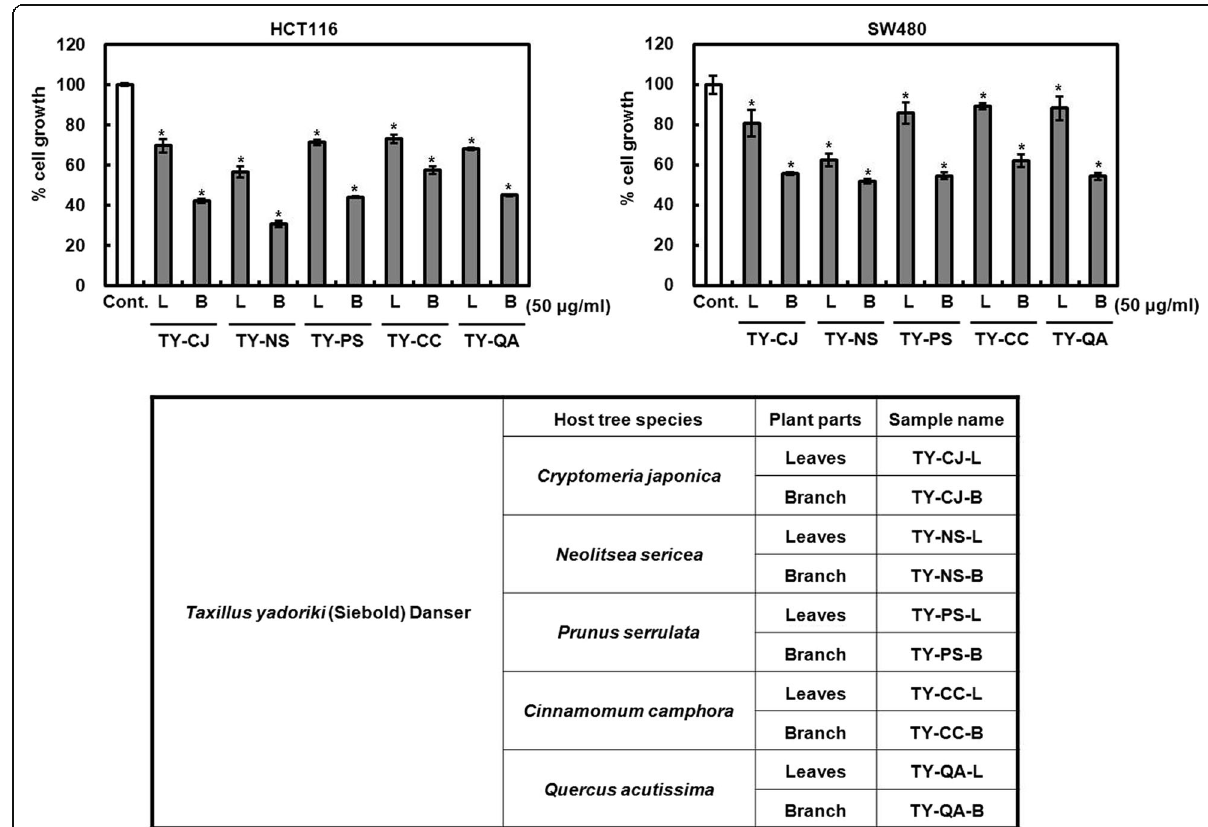
Fig. 1 Comparison of anti-proliferative effect of TY from the host trees and plant parts. HCT116 and SW480 cells were plated overnight and then treated with the samples for 24 h. Cell growth was measured using MTT assay. * P < 0.05 compared to cell without the sample